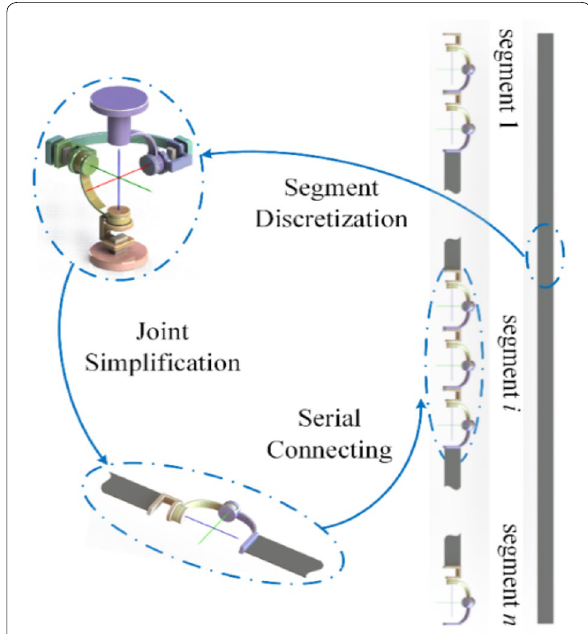
Figure 6 Mechanism approximation of the leaf springs inside the proposed